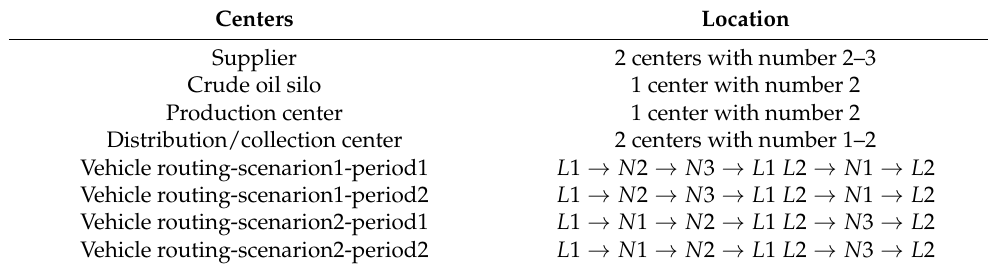
Table 6. Locating and routing the vehicle in the small size problem for the first efficient solution.